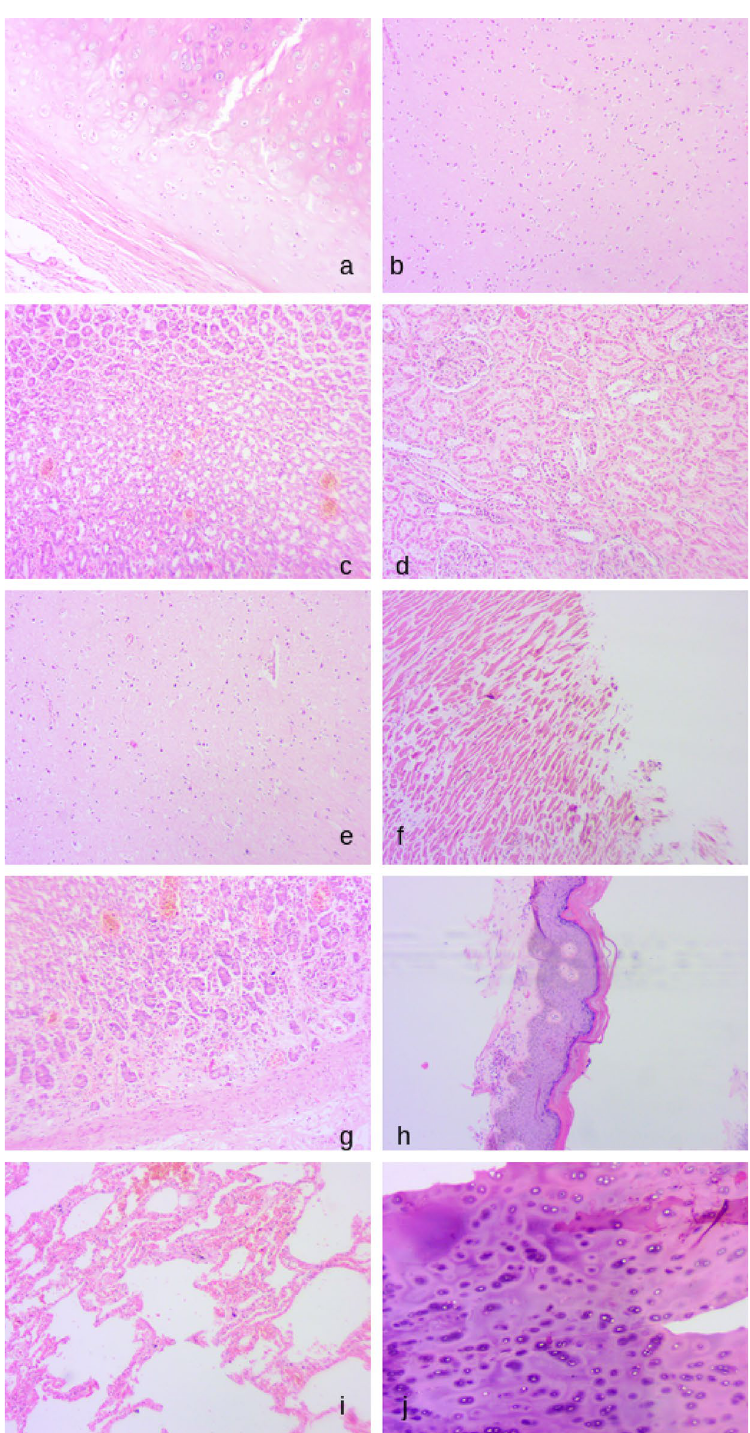
Figure 1. Random sample of images used in the study: ( a ). Trachea, ( b ). Cerebrum, ( c ). Stomach, ( d ). Kidney, ( e ). Cerebrum, ( f ). Heart, ( g ). Stomach, ( h ). Skin, ( i ). Lungs, ( j ). Trachea (Composite figure generated with ImageMagick, version 7.1.0, https:// image magick. org/ index.